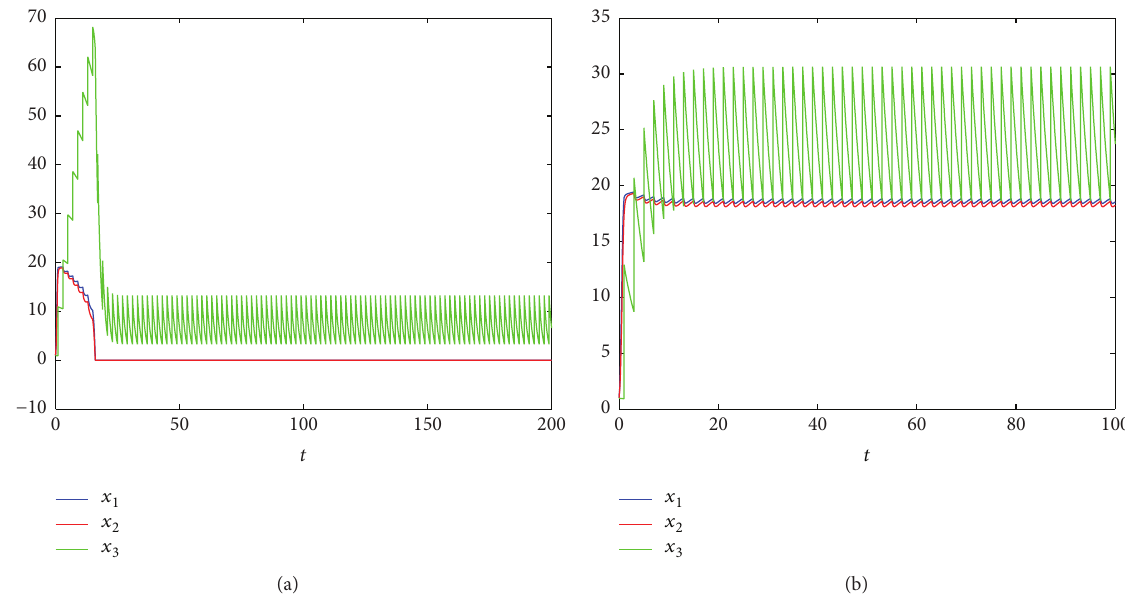
Figure 6: Dynamical behaviors of prey-eradication periodic solution and permanence of the system with single chemical control: (a) is the prey-eradication periodic solution of the single chemical control; (b) is the permanence of the single chemical control.